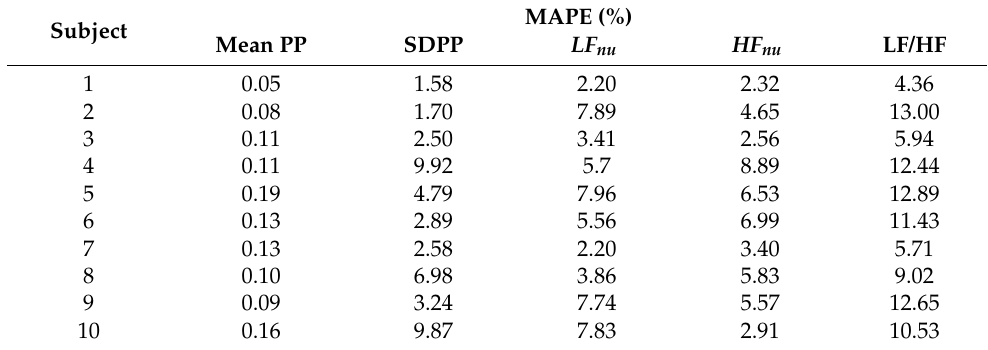
Table 2. MAPE of PRV indicators for NNI for subjects studied